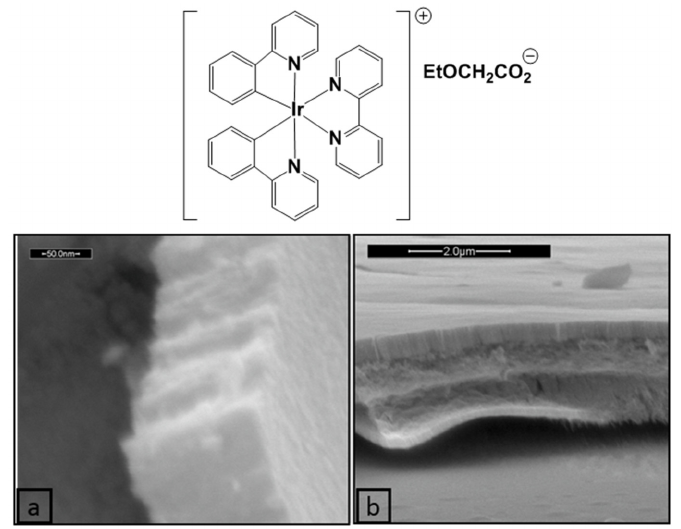
Figure 20. Chemical structure of [(ppy) 2 Ir(bpy)]EtOCH 2 CO 2 and SEM images of the IrO 2 film pre- pared starting from its 5% w / w ( a ) and 6% w / w ( b ) gel phase (Reprinted/adapted with permission from Ref.